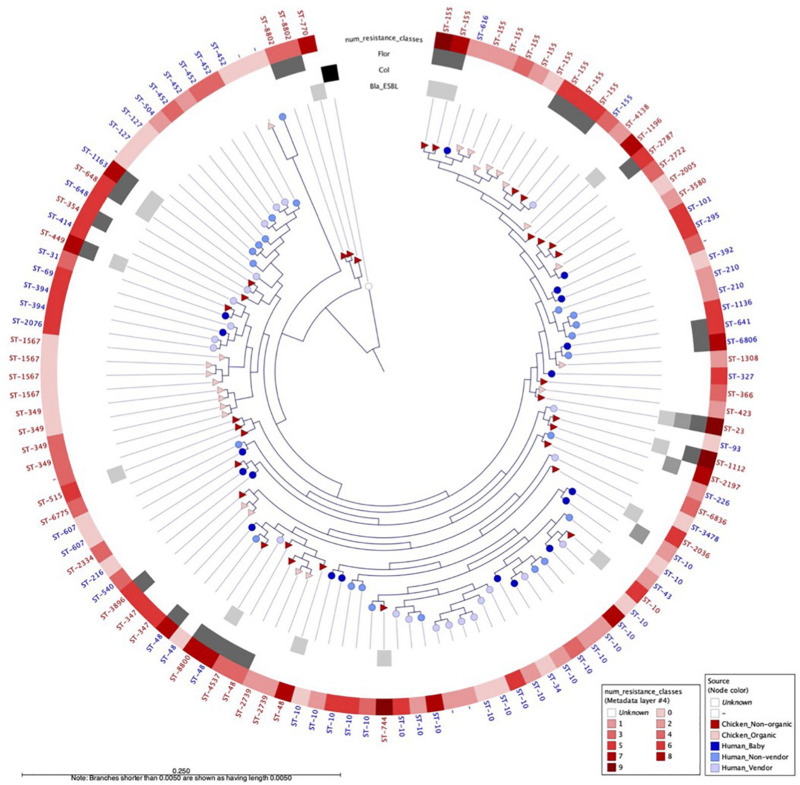
Maximum likelihood phylogenetic tree built from the alignment of 2,233 E. coli core genes from 118 human and animal isolates, using E. fergusonii as outgroup. Nodes are shaped by host type (circle = human, triangle = chicken) and colored by sampling group. Outer gray circles indicate presence of ESBL, mcr-1, and floR genes. Outer red circles indicate the number of antibiotic classes to which the isolate is resistant. WGS-based sequence type (ST) is indicated for each isolate.